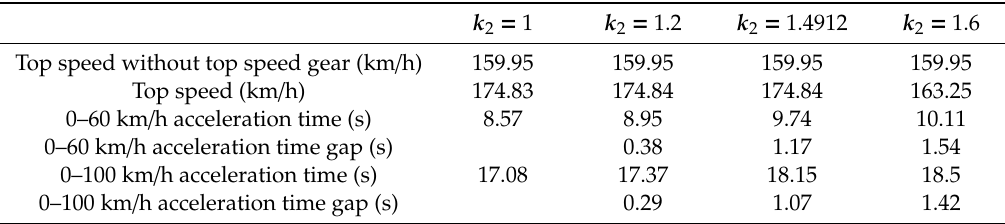
Figure 17. ( a ) Acceleration test with different 𝑘 2 values without top speed gear. ( b ) Acceleration test under different 𝑘 2 values with top speed gear. Table 8. Top speed result and acceleration time with di ff erent k 2 values.